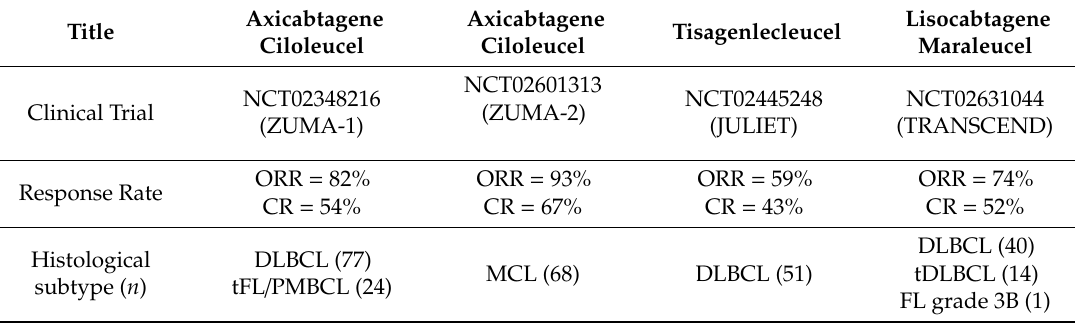
Table 2. CD-19 CAR-T cell-based therapies in R / R B-cell